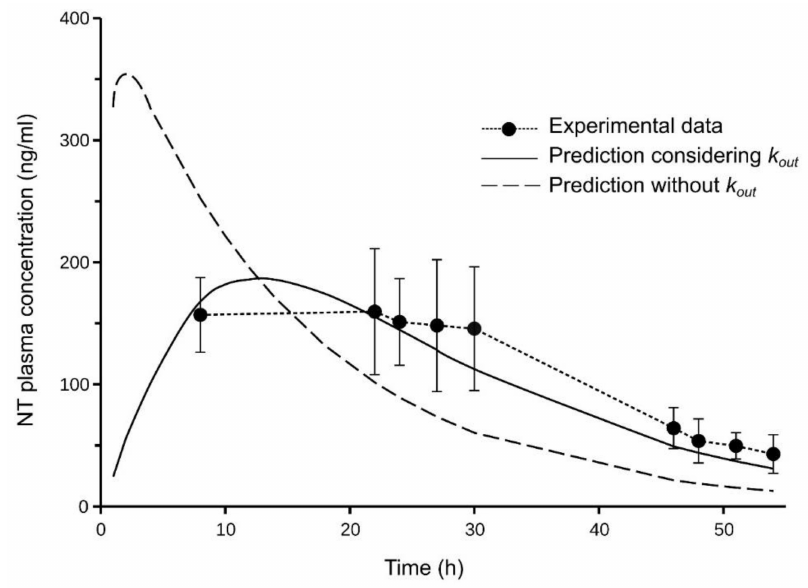
Figure 5. Plasma concentrations of NT (mean ± SD, n = 5) obtained from rats dosed with the NT gel. The continuous curve shows the predicted plasma concentrations using the three-compartment model depicted in Figure 3. The dashed curve shows the predicted concentrations when k out was not considered in the